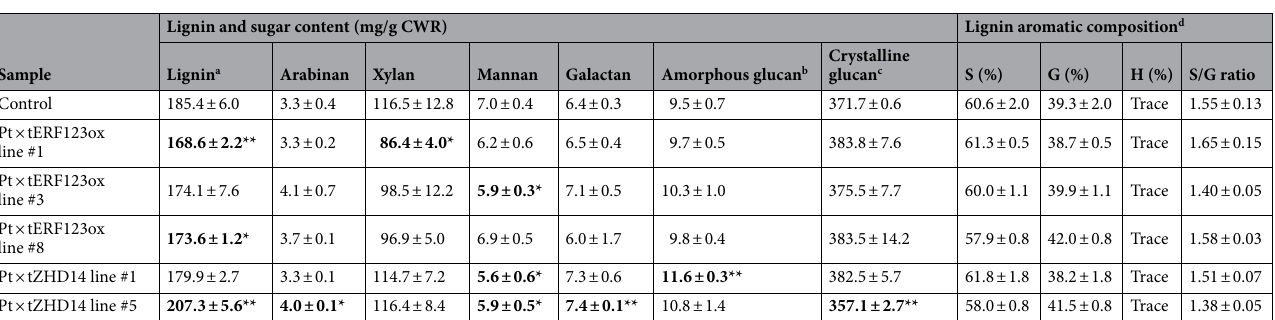
Table 2. Cell wall lignin and polysaccharide analyses of Pt × tERF123ox and Pt × tZHD14ox transgenic hybrid aspens grown in green house. Single and double asterisk(s) indicate P value < 0.05 and < 0.01, respectively, in Student’s t - test ( n ≥ 3) when compared with the control plant. CWR cell wall residues, S syringyl, G guaiacyl, H p -hydroxyphenyl. a Determined by thioglycolic acid assay. b Trifluoroacetic-acid-soluble